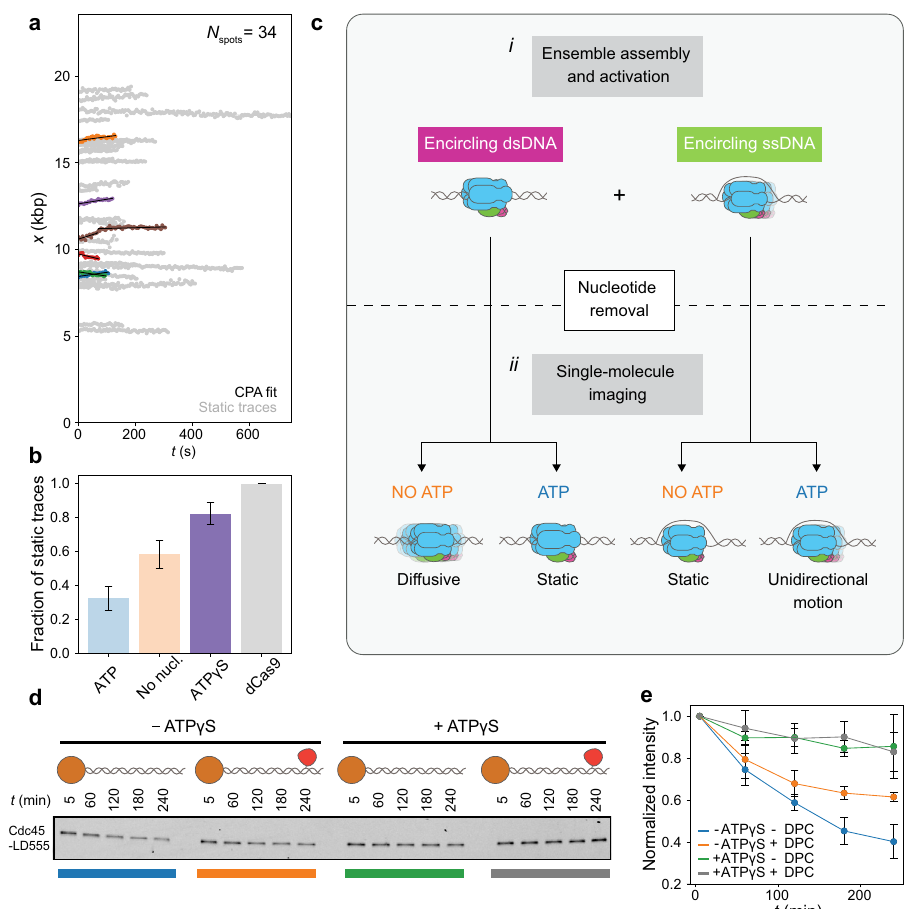
Fig. 4 | Nucleotide binding haltsCMGdiffusion. a Position vs. time plotsofCMG spotsinthepresenceofATP γ S;CPA fi tsareplottedinblack,statictracesareshown in light gray and mobile traces are shown in all other colors. b Fraction of static CMG spots in the presence of ATP γ S ( N spots =34); the results from Fig. 2d, are shown as light bars for comparison; error bars show the standard error of pro- portion. c Model proposed to explain experimental motion results; c - i proposed two populations of CMG present in the ensemble CMG activation reaction; c-ii summaryofexperimentaloutcomesinFigs.2and4a,andproposedexplanationof